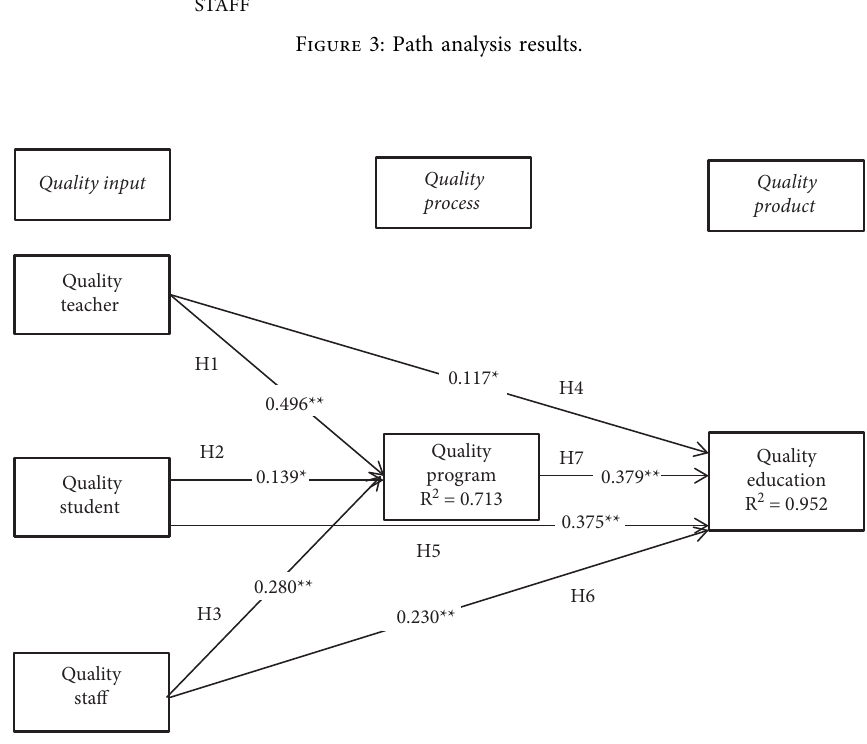
Figure 4: Evaluated